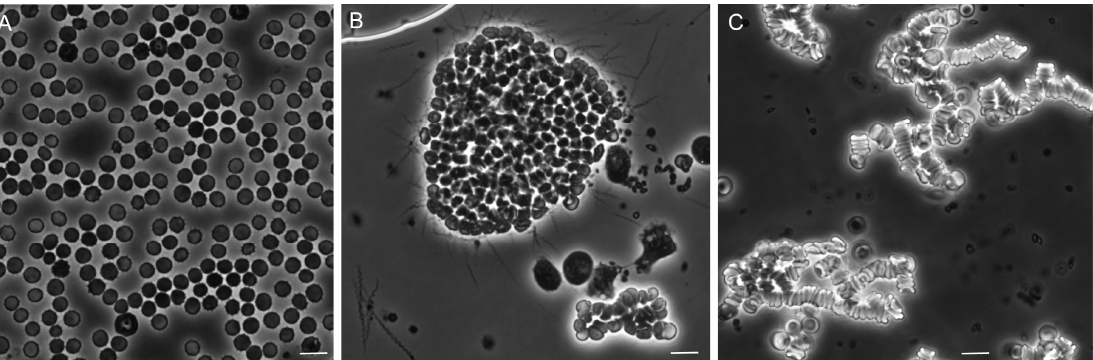
Figure 10. Phase photomicrographs of uninfected mouse blood mixed with equal volumes of plasma from uninfected SCID mice (panel A ); plasma from B. hermsii -infected BALB/c mice (panel B ); and plasma from infected mice that had been centrifuged (panel C ). In panel B numerous spirochetes are seen singly, in clumps, and adhered to the aggregate of blood cells. Panel C is an example of rouleaux formation. The size marker in each panel is 10 μ m.